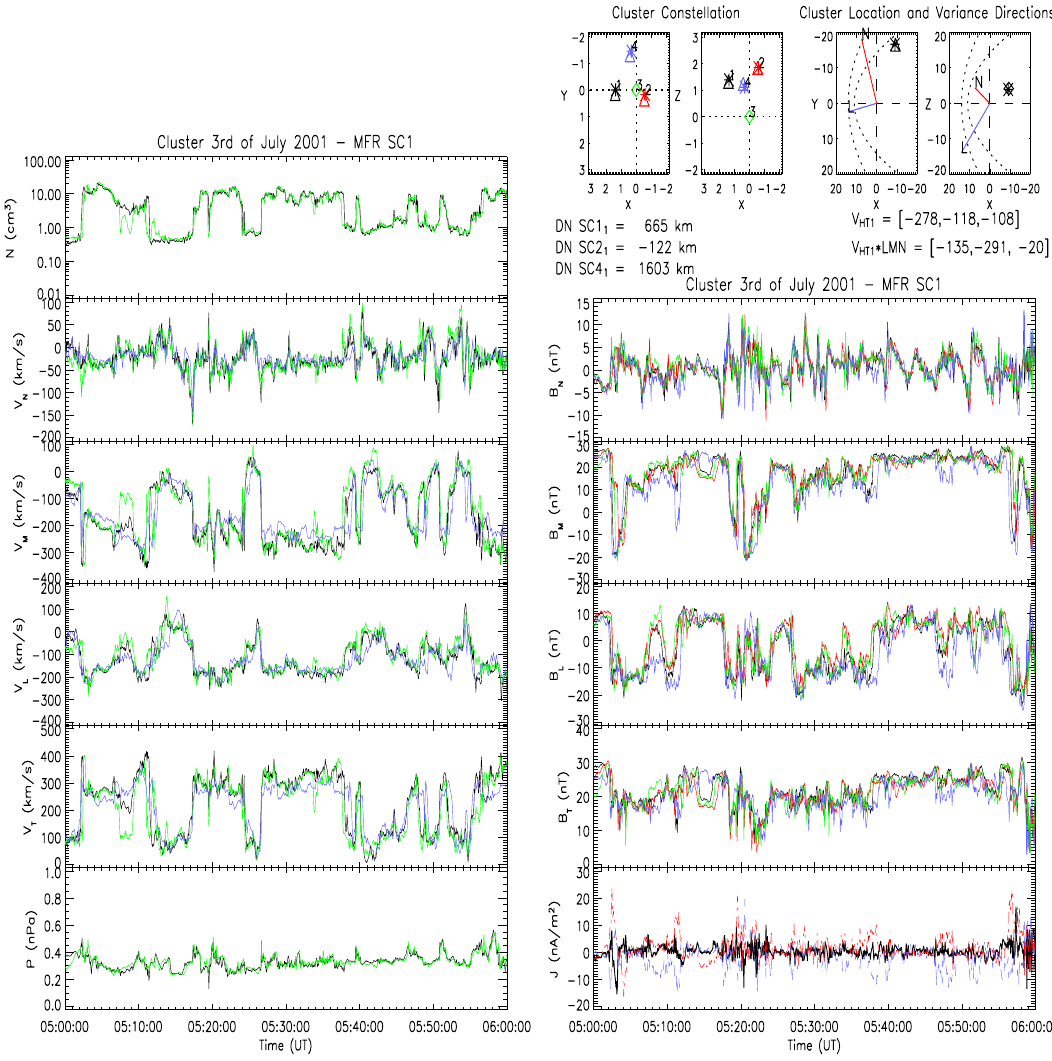
Fig. 5. Cluster plasma (left) and magnetic field observations (right) in LMN coordinates determined by data of sc1 with MFR method on 3 July 2001 between 05:00–06:00 UT. Figure uses same format as Fig. 4, but instead of plasma temperature, the total pressure (ion plus magnetic) is shown in bottom left